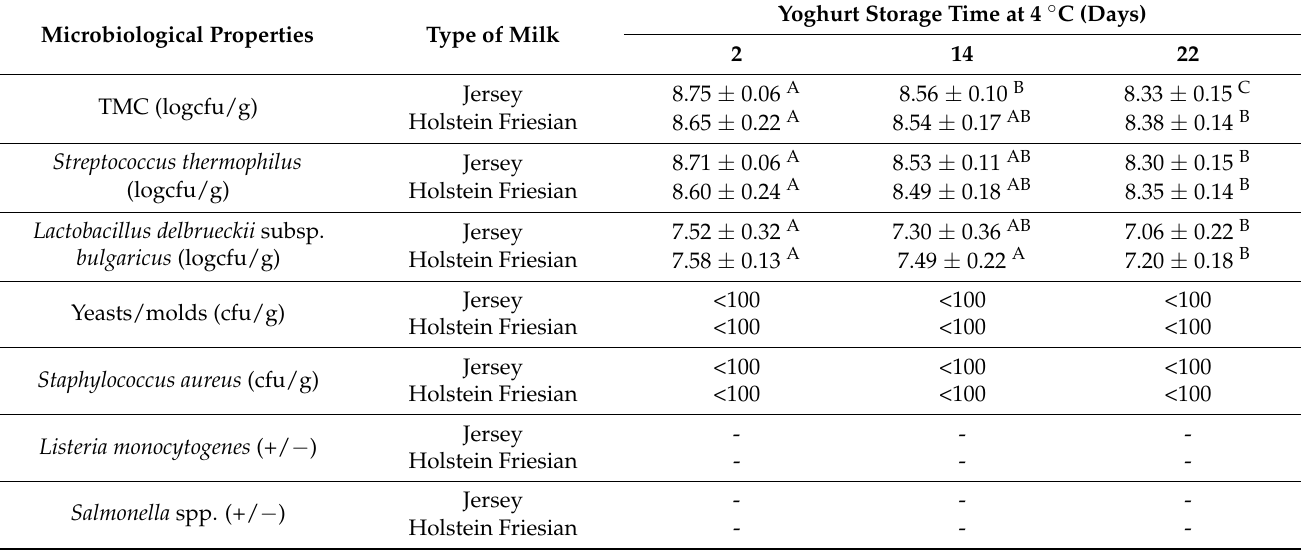
Table 4. Microbiological properties of traditional-type Greek yoghurts during the safe consumption period of the product (22